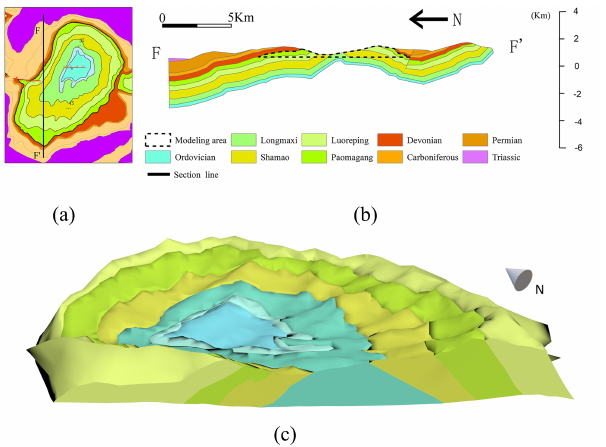
Figure 14. The internal stratigraphic structure of the Wulongshan dome: ( a ) geological map of Wulongshan dome; ( b ) geological section of the dome taken along the line FF’ in ( a ) [49]; ( c ) vertical section model of Wulongshan dome.